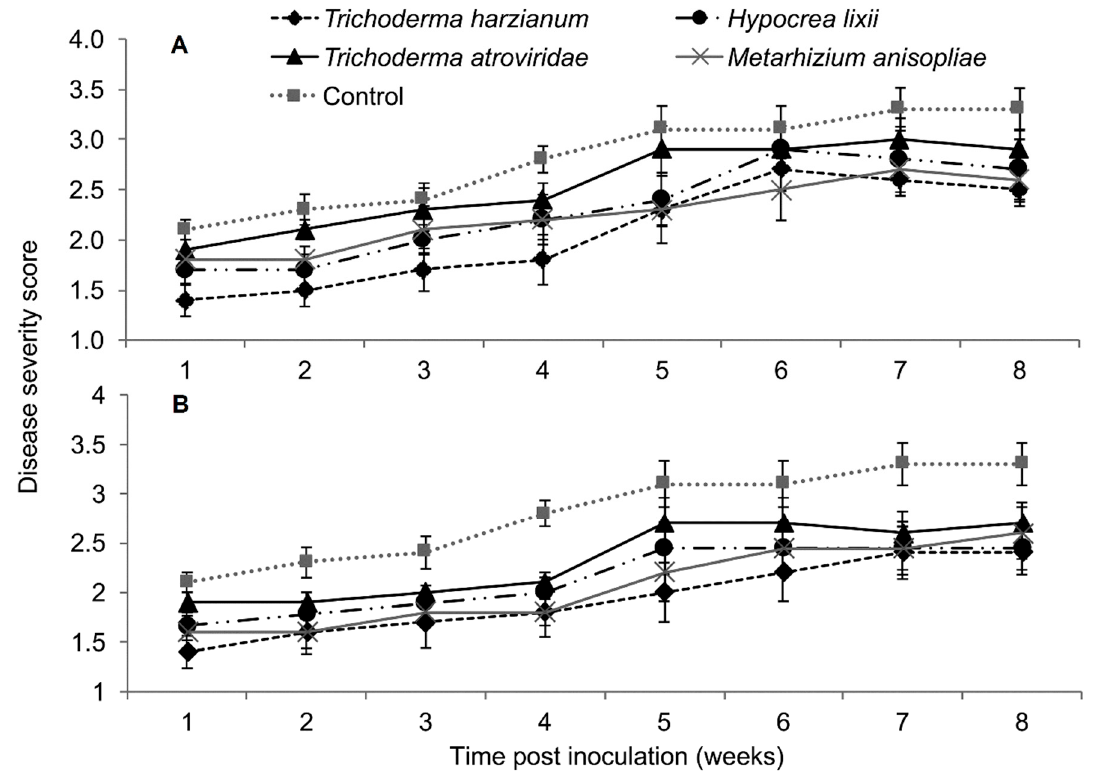
Figure 4. Severity of Sugarcane mosaic virus disease as influenced by different treatments over time in trial one ( A ) and two ( B